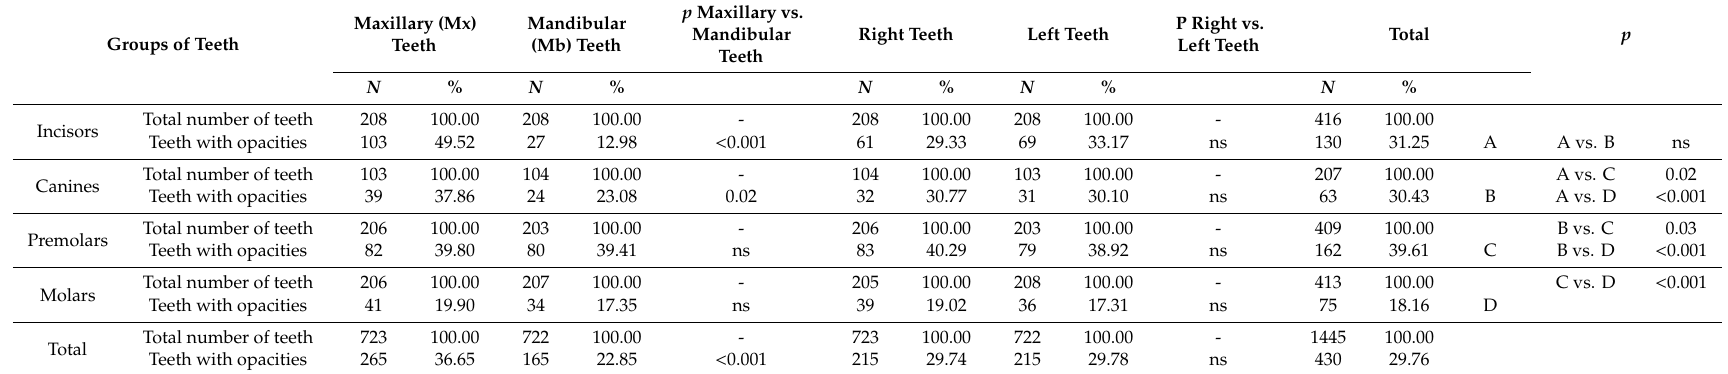
Table 7. Number of teeth groups present in the oral cavity and those a ff ected by enamel opacities with respect to the dental arch (maxillary and mandibular) as well as to the side of the oral cavity (right and left).